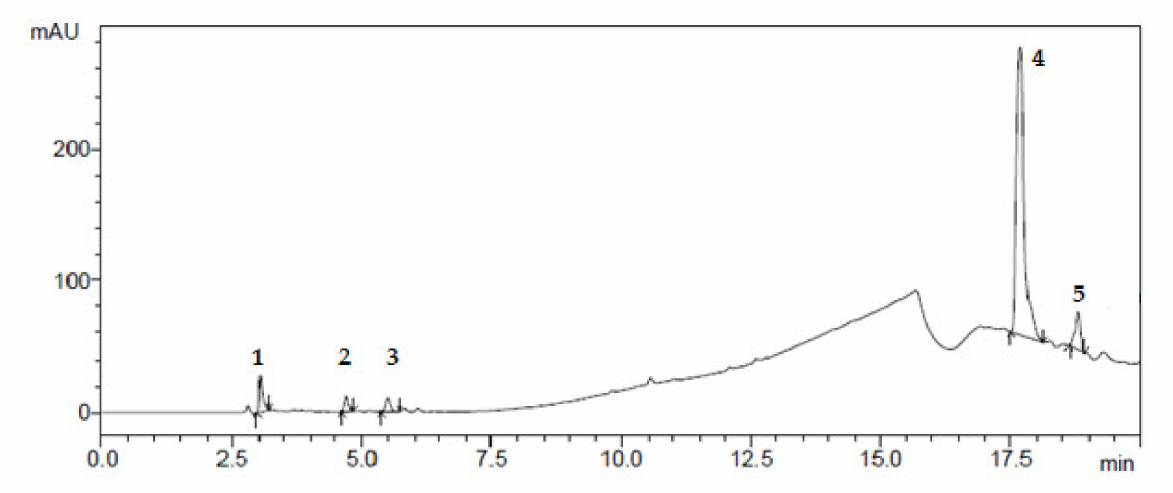
Figure 2. Preparative isolation of BAS from Dactylorhiza maculata extract samples: (1) disulforetin; (2) sulfuretin; (3) sulfurein; (4) quercetin; (5)